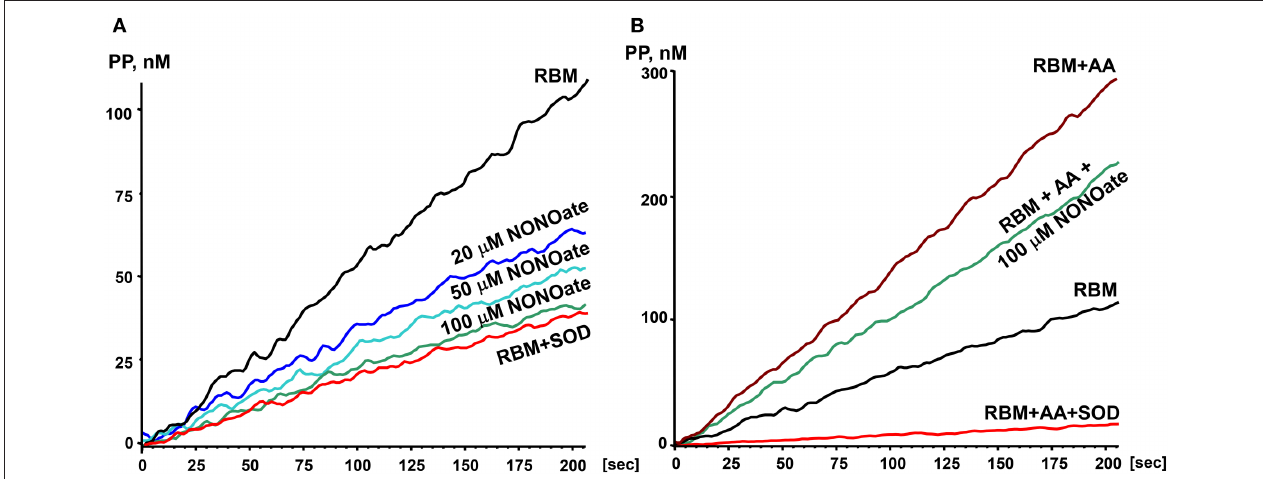
FIGURE 1 | Effect of nitric oxide on O 2 • release by rat brain mitochondria. Rat brain mitochondria (RBM) were placed in respiration media with Glutamate/Malate as a substrate and acutely treated with slow releasing NO-donor DPTA Nonoate (A) . To test the potential effect of NO on complex III-mediated O 2 • production mitochondria were supplemented with complex III blocker Antimycin A (1 µ M) (B) . Release of mitochondrial O 2 • was measured by spin probe PPH (1mM) and accumulation of PP-nitroxide followed by ESR spectrometer as described in Material and Methods. Addition of Cu,Zn-superoxide dismutase (SOD, 10 Units/ml) confirms specific detection of extramitochondrial O 2 • . Figure shows typical ESR data of four independent experiments.